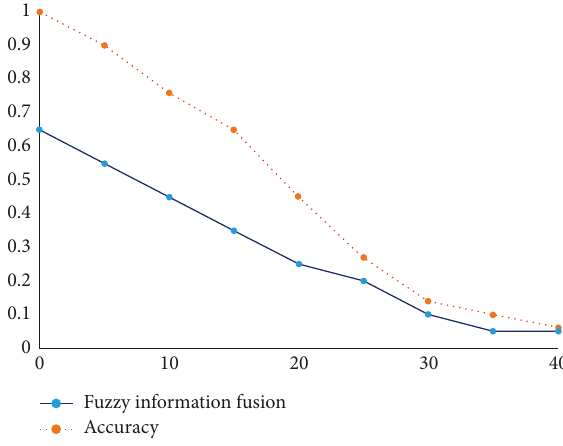
Figure 2: The curves of low texture with